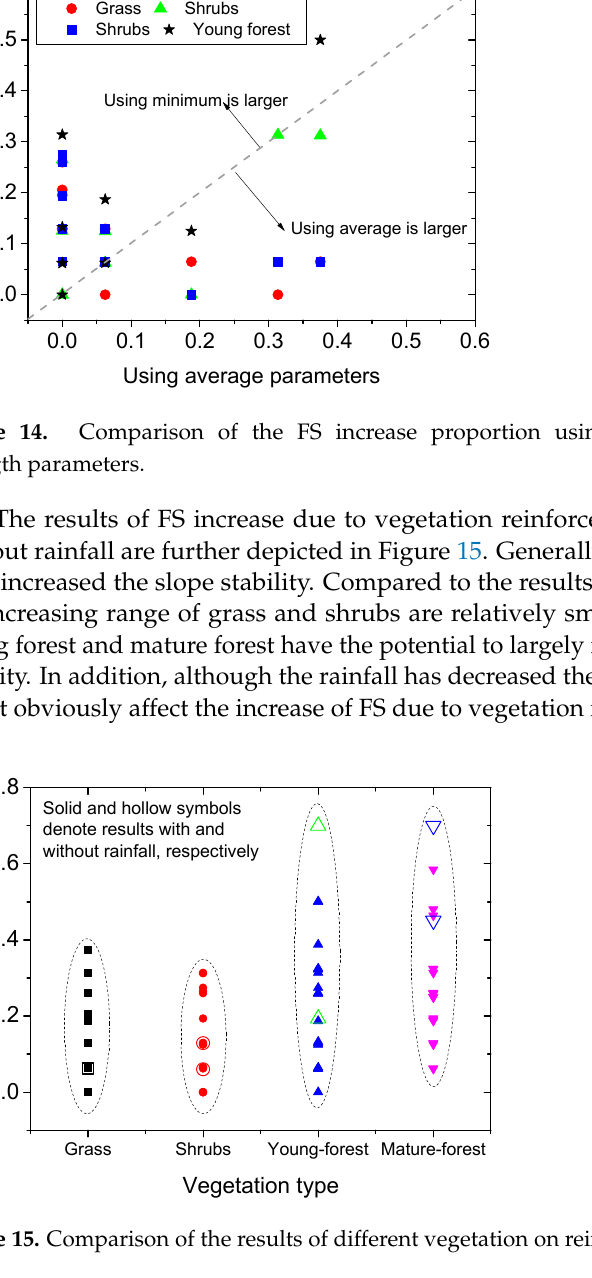
Figure 13. Comparison of the factor of safety for the cases with accumulative rainfall amount of 100 mm and no rainfall using both average and minimum soil strength parameters.